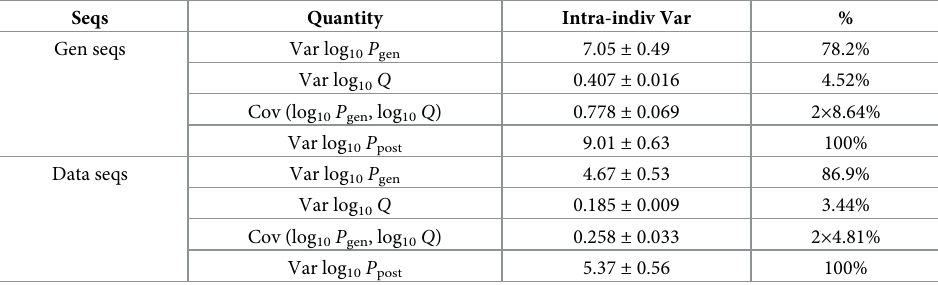
Table 1. Intra-individual variation.